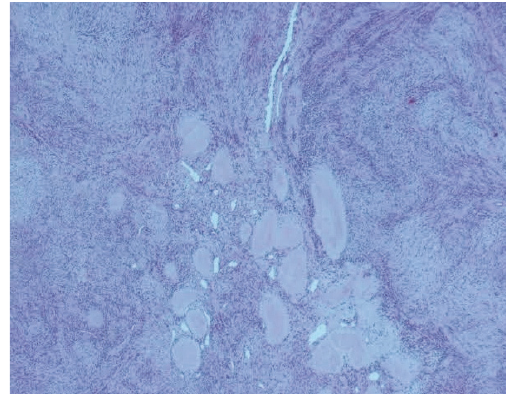
Figure 4: Acellular material accumulation with homogeneous eosinophilic appearance called “amianthoid fibers” (HE, 100x).